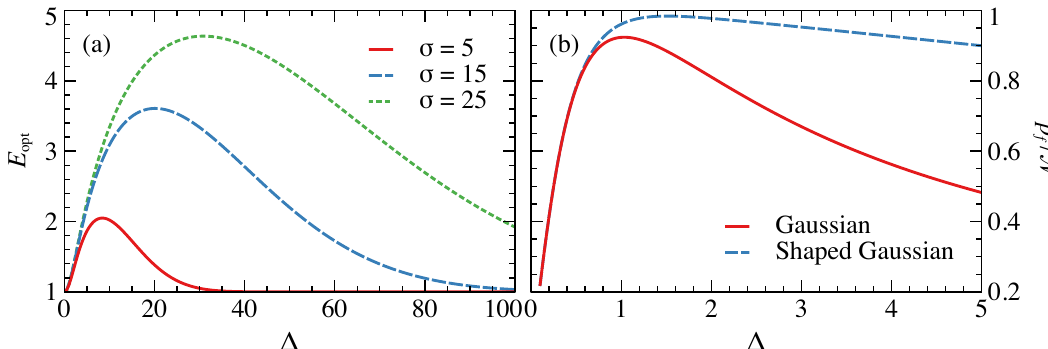
Figure 5: (a) Optimization ratio E (61) as a function of ∆ (51), obtained by opt optimally shaping a realistic the two-photon wave function (62), given the single- photon Gaussian profile (68), for three different values of the latter’s width σ . (b) Maximum achievable population, in units of N (31), for optimally shaped [ (65), solid line ] and unshaped [ (62), dashed line ] , realistic two-photon wave functions, with Gaussian single-photon profiles (68) of width σ = ∆ , with ∆ ≥